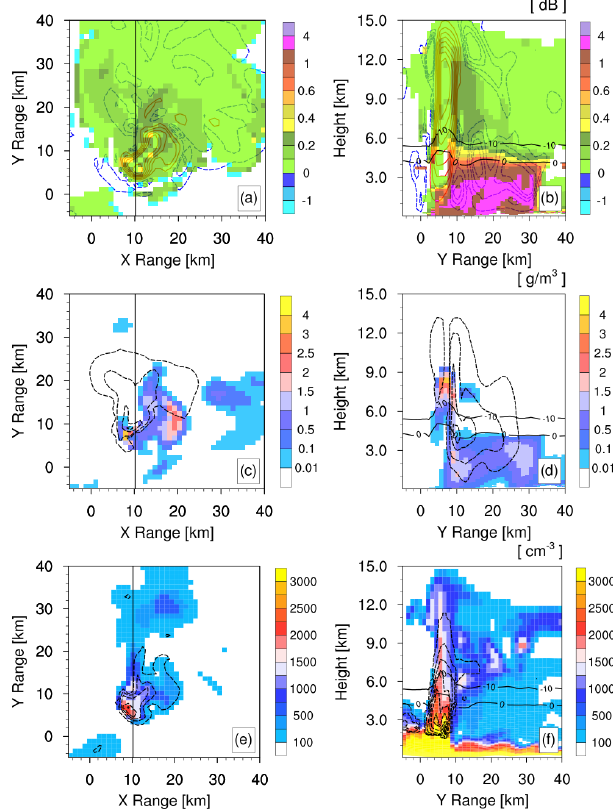
Figure 11. Plan view (a) and vertical cross section (b) of aerosols, model states, and polarimetric variables. The plan views are shown at 6km height, and all cross sections passing through the solid line are shown in the plan view. The 0 and − 10 ◦ C isotherm is also shown in all cross sections. (a, b) Differential reflectivity (color fill) and vertical velocity (lines). The contoured solid/dashed red/blue lines indicate updraft and downdraft, respectively. The vertical wind speed contours are shown at the following intervals ( − 7 . 0, − 5 . 0, − 3 . 0, − 1 . 0, 5 . 0, 10 . 0, 15 . 0, 20 . 0, 25 . 0, 30 . 0, 35 . 0, 40 . 0) in me- ters per second. (c, d) Rain and hail mixing ratios in filled and solid line contours, respectively. (e, f) Aerosol and cloud number concen- trations in filled and dashed line contours, respectively. The cloud number concentration is contoured at interval of 500cm − 3 , with a minimum of 100cm − 3 . The aerosol concentration is shown for the pure and mixed nucleation and accumulation model